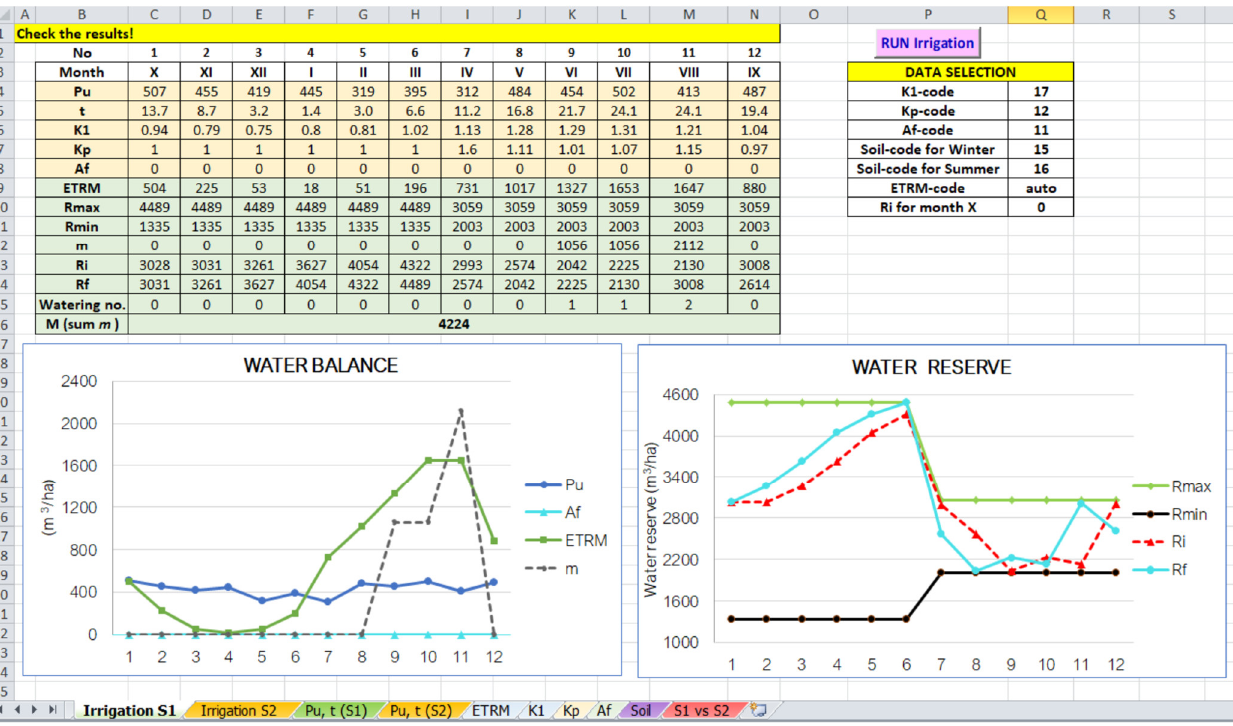
Figure 17. Output for alfalfa at CT, computed using the Thornthwaite equation.